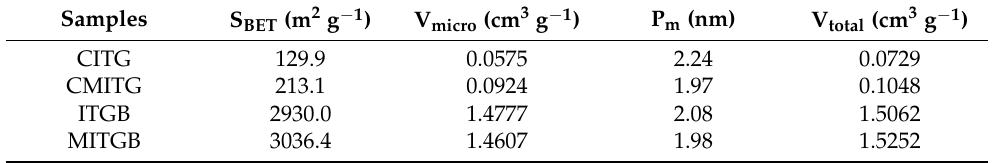
Figure 4. The ( A ) N 2 adsorption-desorption isotherms and pore size distribution curves of CITG, CMITG, ITGB, and MITGB based on ( B ) NLDFT method, ( C ) BJH method, and ( D ) H-K method. Table 1. The data of N 2 adsorption-desorption for CITG, CMITG, ITGB, and MITGB.